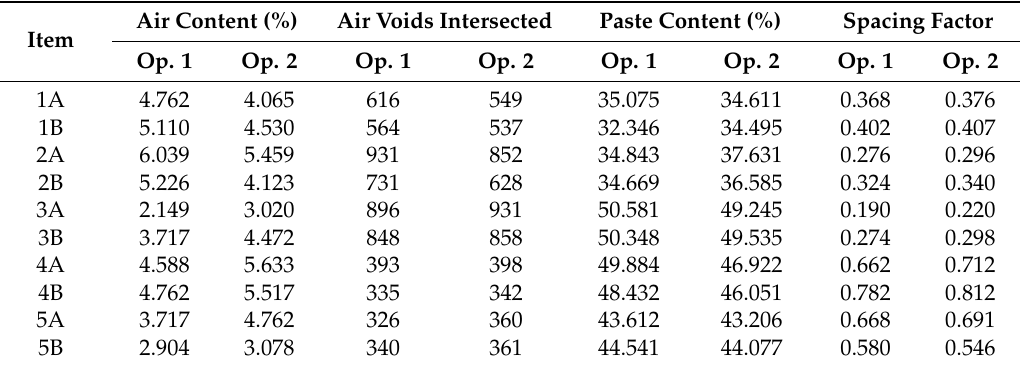
Table 2. Comparison of values obtained on 10 specimens (five dosages with two slabs per dosage) by two operators using the method proposed in this